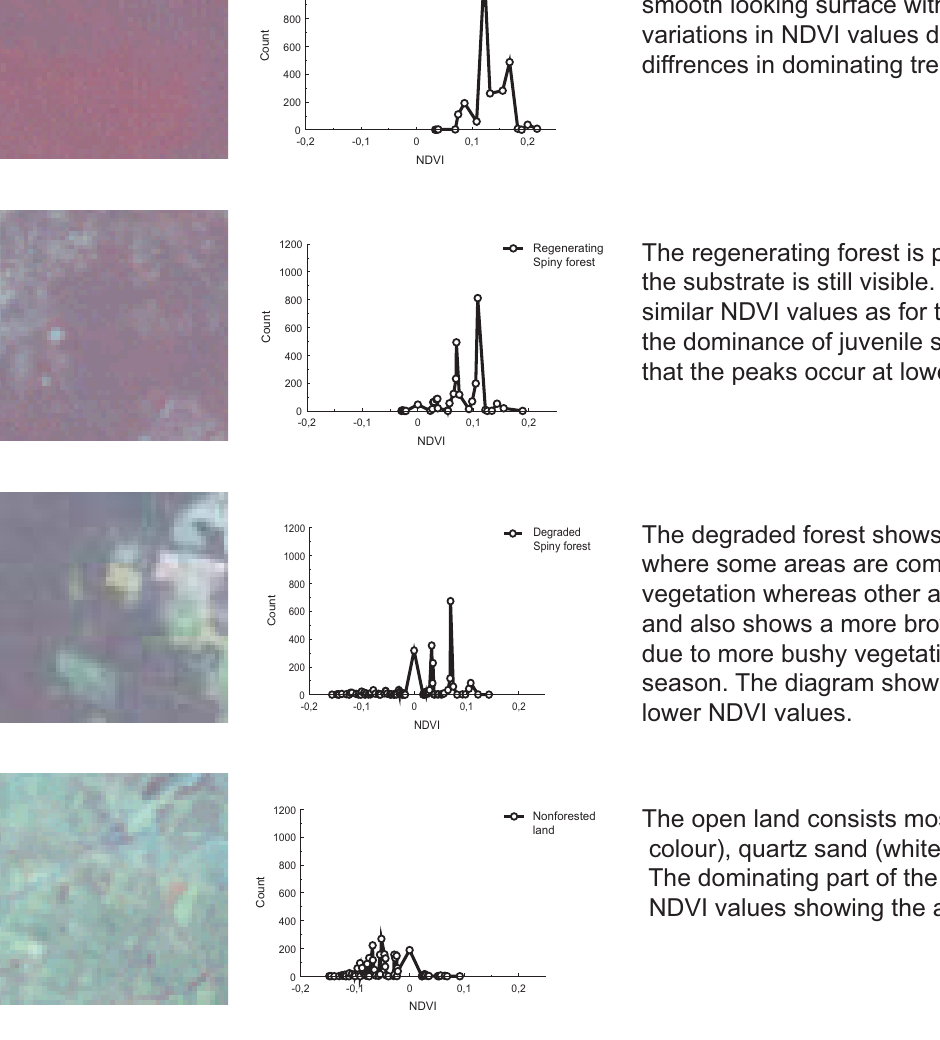
Figure 4. In the NDVI analysis (Normalised Difference Vegetative Index), the dense mature forests show multiple peaks due to differences in species composition, the regenerating forest is separated with lower NDVI values, while degraded forest and open land has distinctly different patterns. The examples given here are subsets (1.5 6 1.5 km) from the 2000 Landsat 7ETM + image.